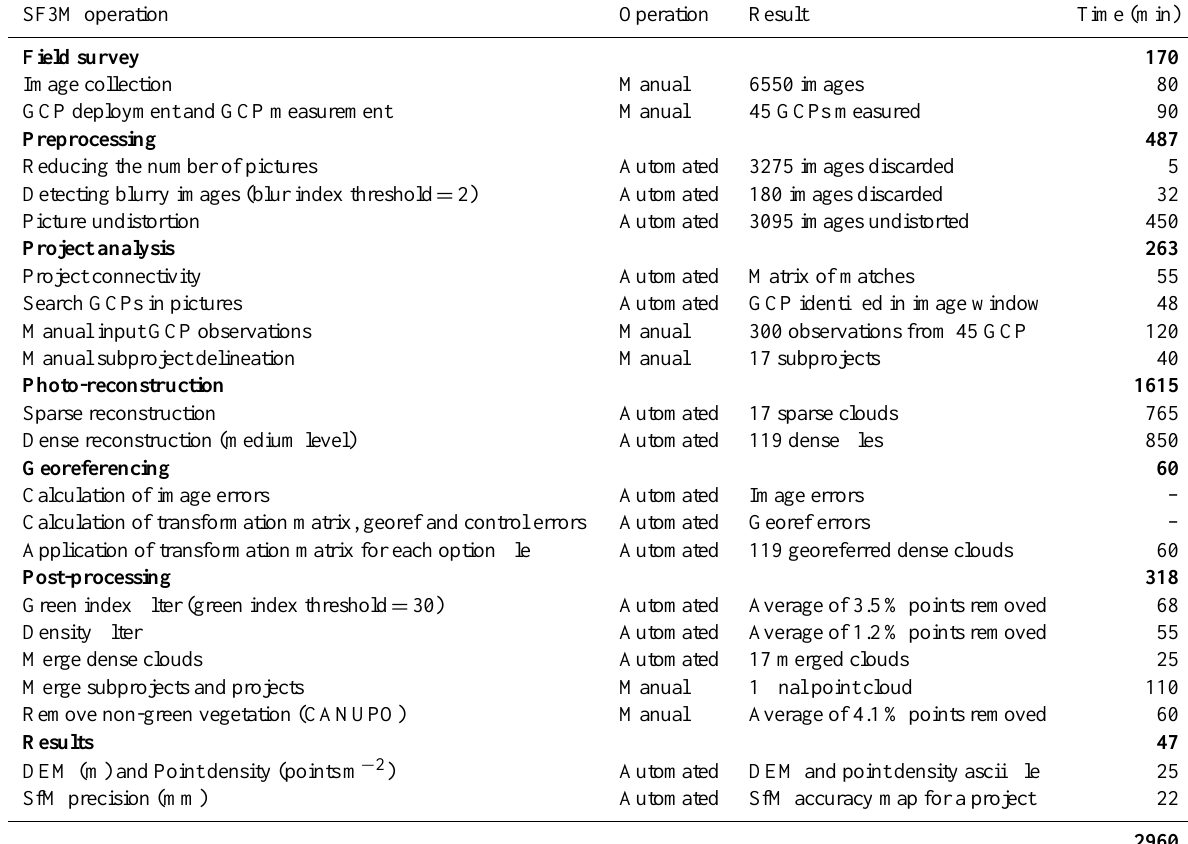
Table 2. Field and processing time requirements grouped by stages (in bold) for the entire gully network. Main results and type of operation are included.